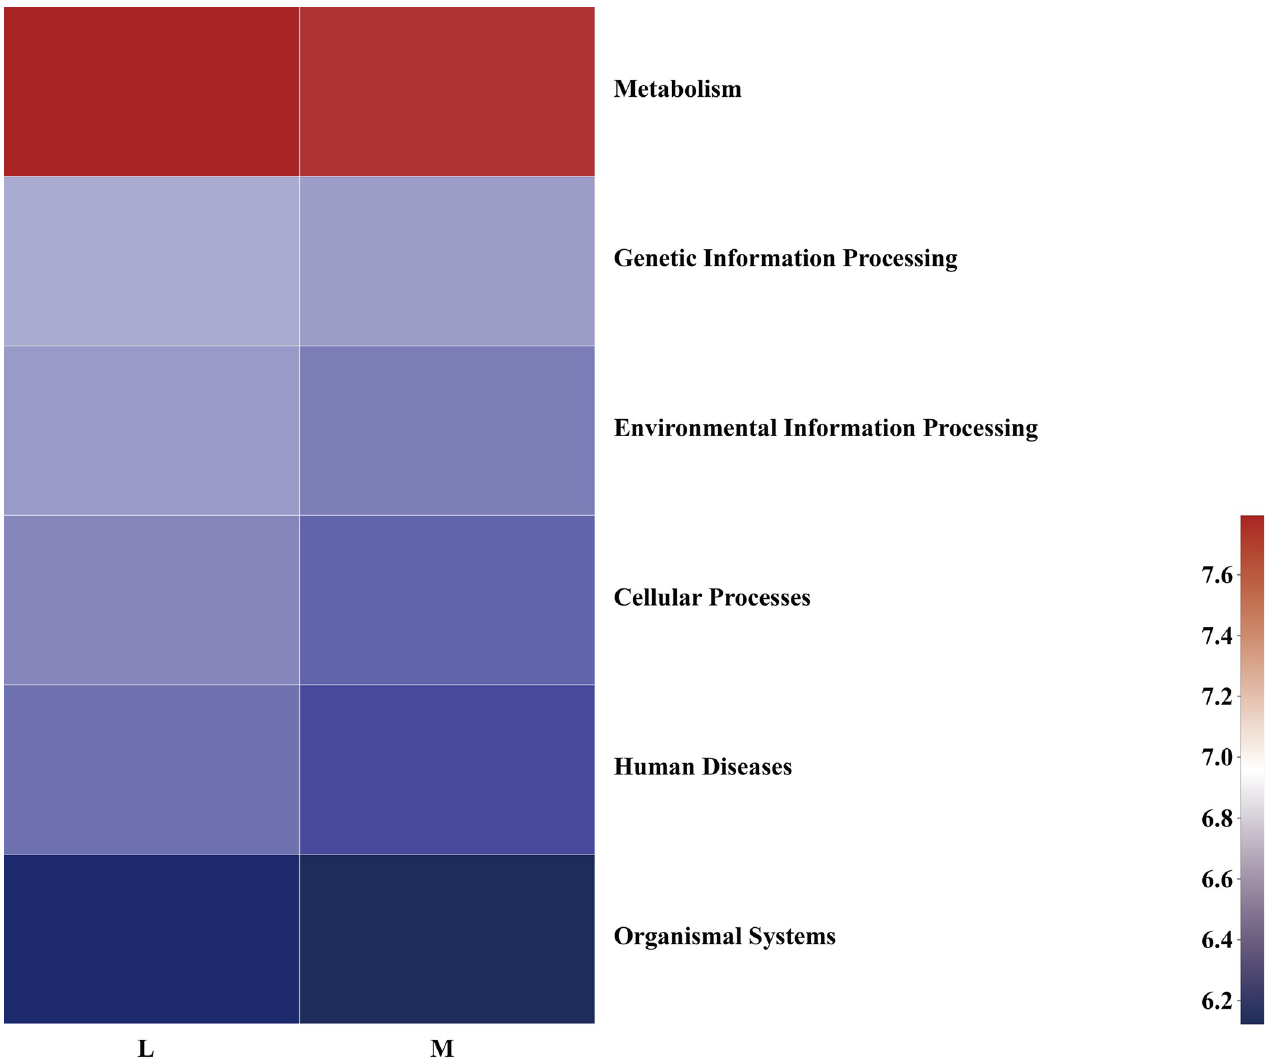
Fig 8. Variations in predicted soil bacterial functional profiles between moss (M) and non-moss growth(L) areas in litchi orchard (hierarchy level